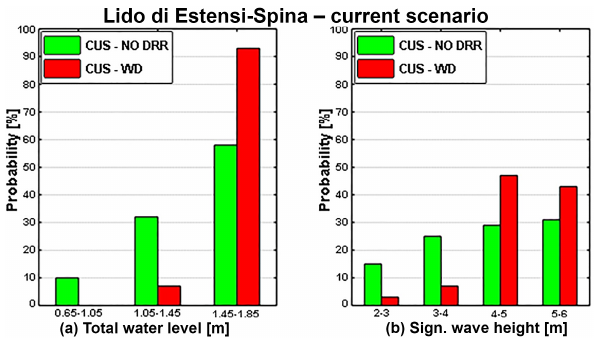
Figure 16. Distribution of boundary conditions ( a TWL and b Hs) for constrained uniform flood damages in the current scenario for Lido degli Estensi–Spina. The configuration without measures (green bars) and for the implementation of the winter dune (red bars) were compared.